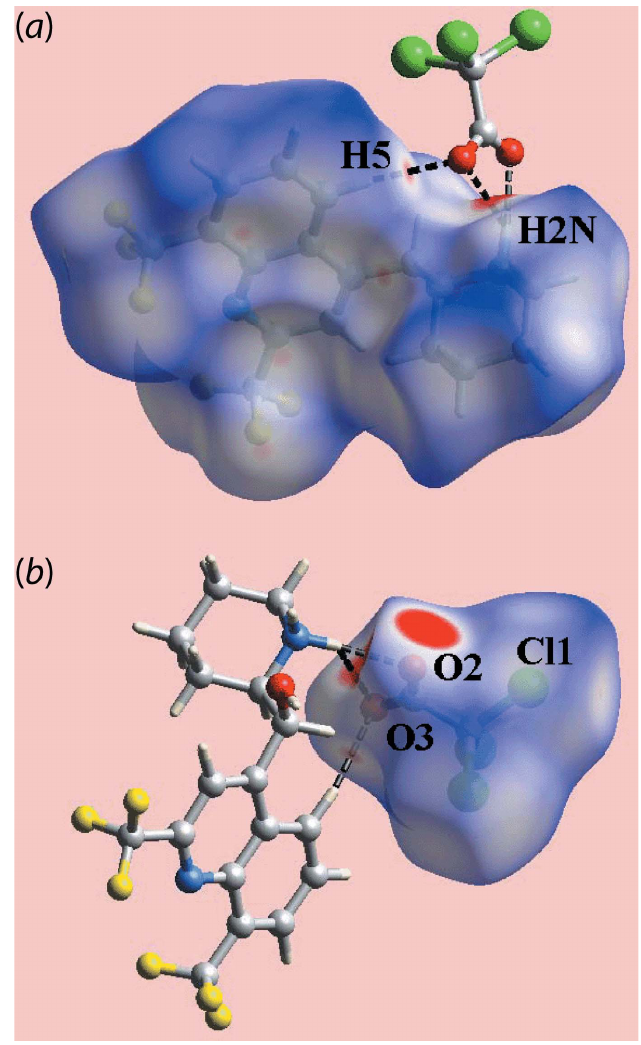
Figure 3 Views of the Hirshfeld surface of (I) mapped over d norm in the range (cid:3) 0.171 to +1.475 a.u. for the ( a ) cation and ( b ) anion, highlighting N— H (cid:2)(cid:2)(cid:2) O and C—H (cid:2)(cid:2)(cid:2) O contacts as black dashed lines.